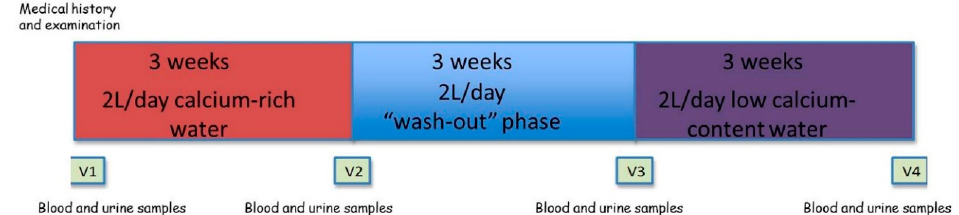
Figure 1. Schematic representation of the study design and procedures. V1: baseline medium-mineral calcium-rich water. V2: +3 weeks of calcium-rich water. V3: baseline low mineralized and low calcium-content water. V4: +3 weeks of low calcium-content water.